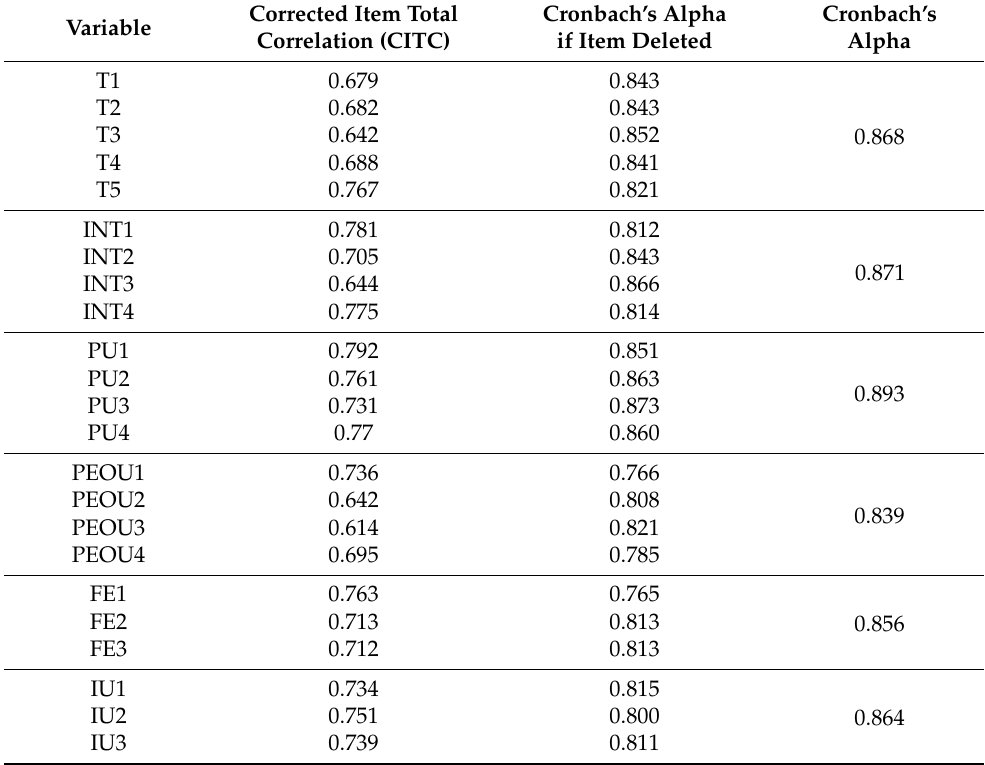
Table 2. Reliability analysis: Cronbach’s